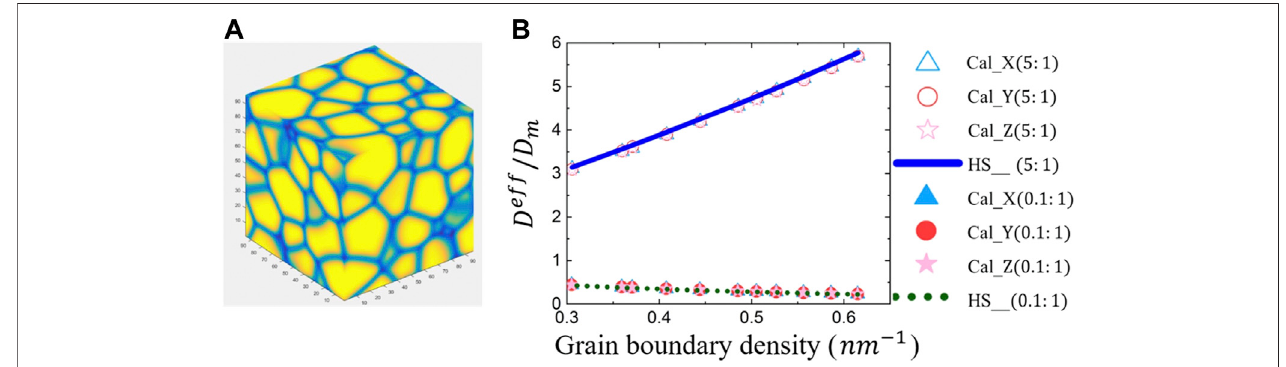
FIGURE3|(A) Thesimulatedisometricpolycrystallinemicrostructure.Bluelinesaregrainboundariesandtheyellowpartsaregrains. (B) Comparisonbetweenthe simulatedandanalyticaleffectivediffusioncoef fi cientsasafunctionofthegrainboundarydensityalonethreedifferentdirectionswithdiffusioncoef fi cientratiosofHinthe grain boundary to that in matrix phase are 0.1:1.0 and